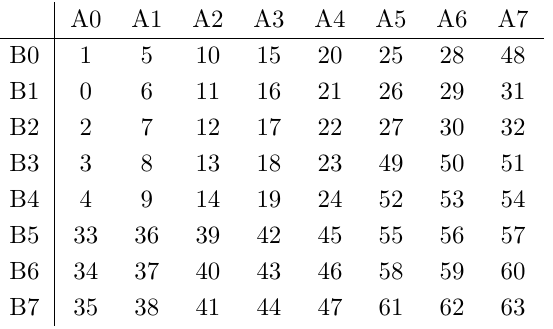
Table 2: Sequence of executing the 64 partial products of words A i × B j used for schoolbook multiplication of 256 bit operands.